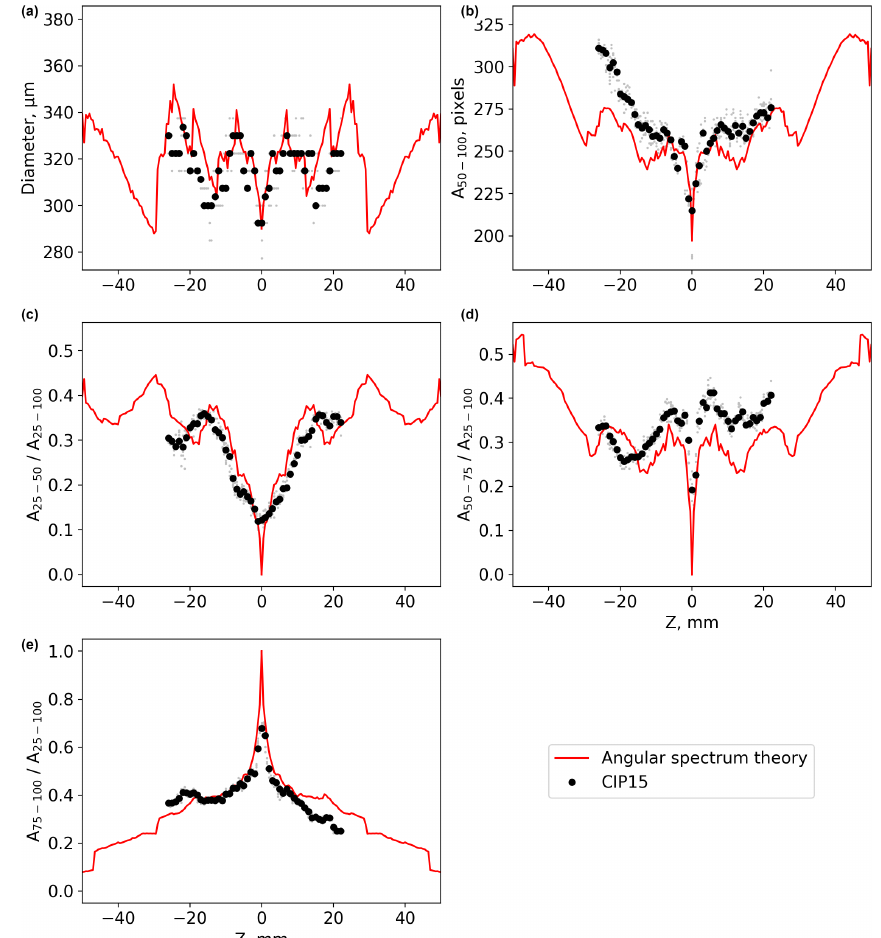
Figure 7. Same as Fig. 5 but for the ice crystal analogue ROS300.